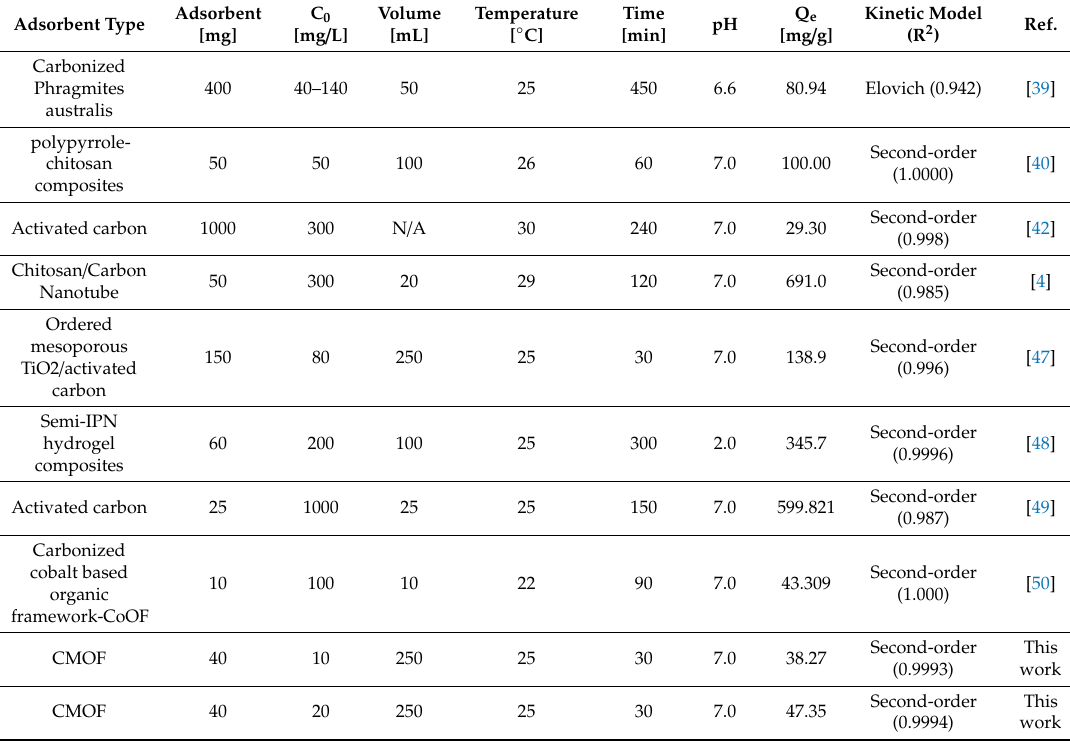
Table 2. Comparison of acid red 18